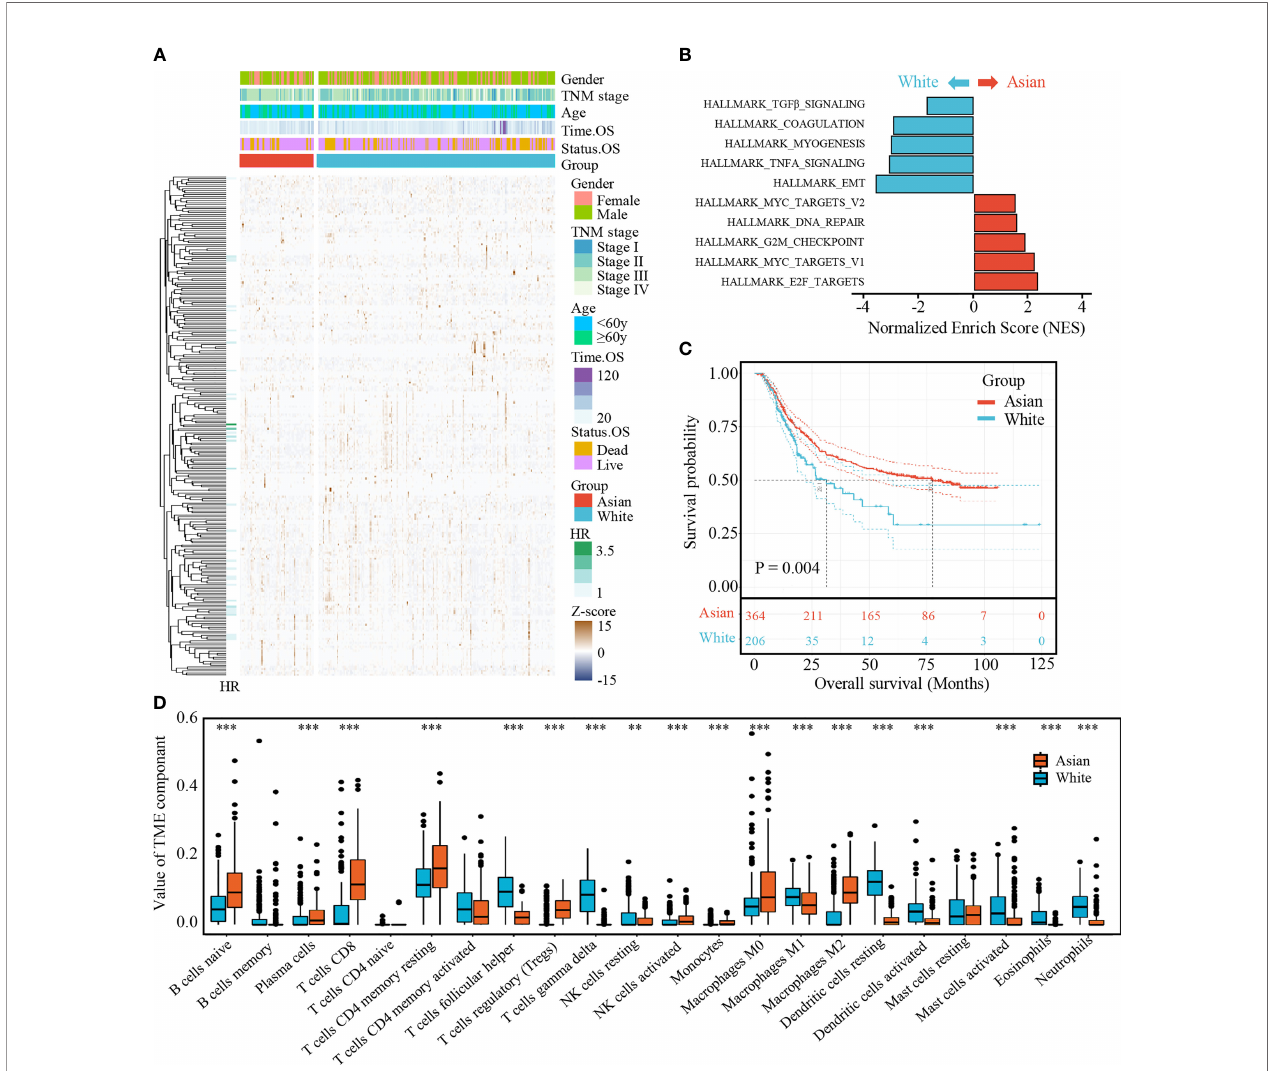
FIGURE 2 | (A) Expression pro fi le of 250 IRGs in TCGA-STAD Asian cohort and TCGA-STAD white cohort. (B) Gene set enrichment analysis (GSEA) of hallmark gene sets. (C) Kaplan-Meier curves for overall survival of Asian cohort and white cohort. The number of patients in Asian cohort and white cohort are n = 364 and n = 206, respectively. The statistical difference between three survival curves was tested by log-rank test. (D) The boxplot of TME component in two cohorts. Within each group, the scattered dots represent TME fraction expression values. The thick line represents the median value. The bottom and top of the boxes are the 25th and 75th percentiles (interquartile range). **P < 0.01 and ***P <